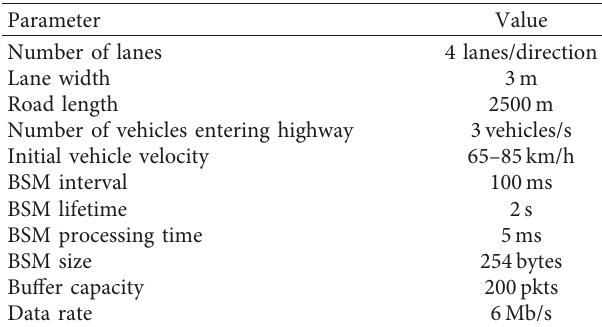
Table 2: Simulation